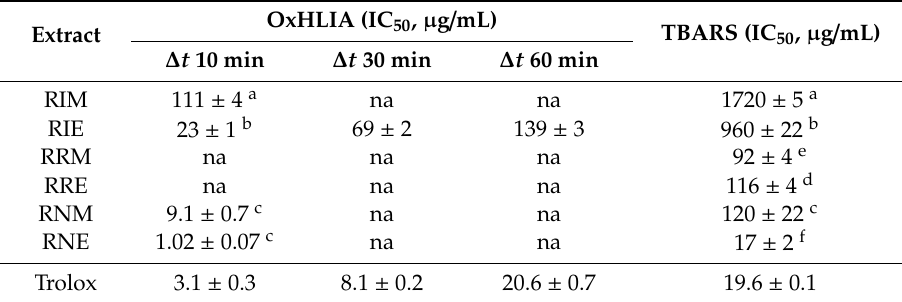
Table 4. Antioxidant properties of the studied extracts (mean ± SD, n = 3).